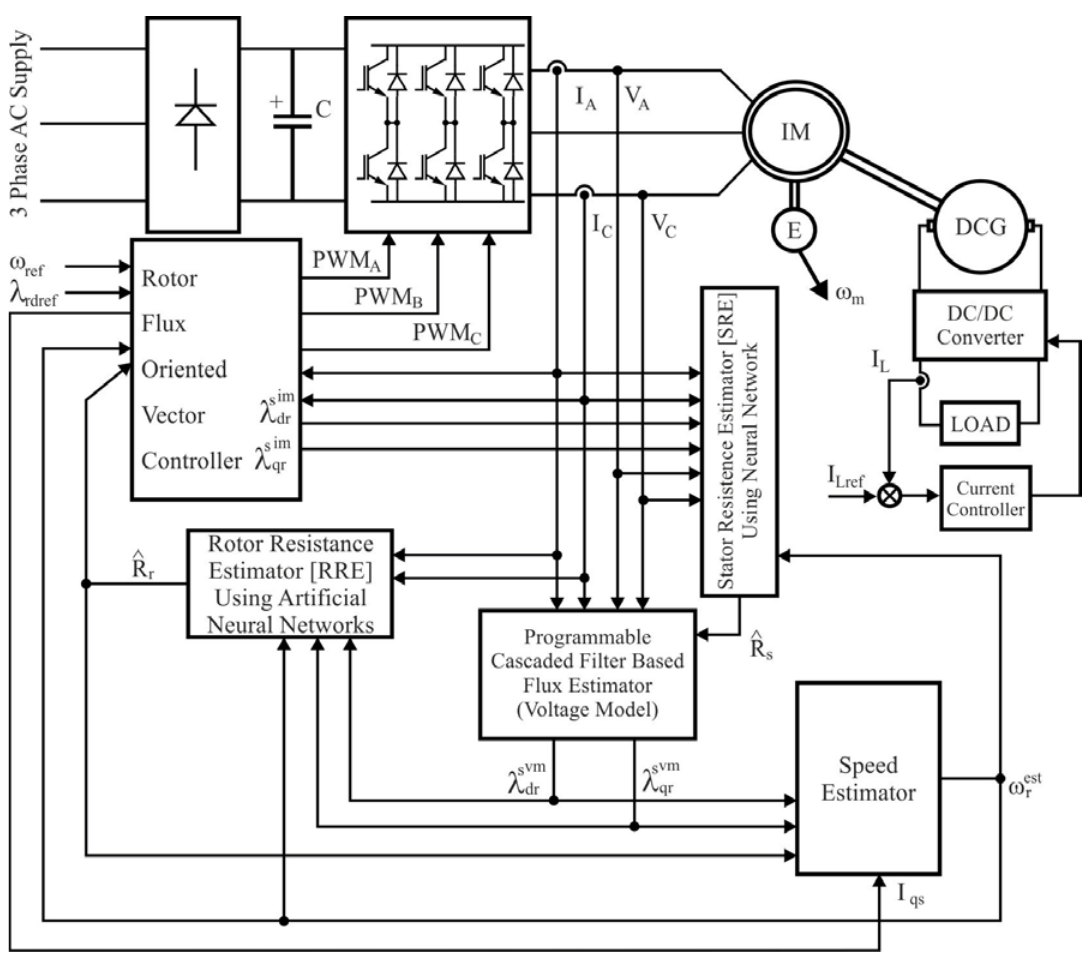
Figure 20. Block diagram of the indirect vector controlled induction motor drive with online stator and rotor resistance tracking